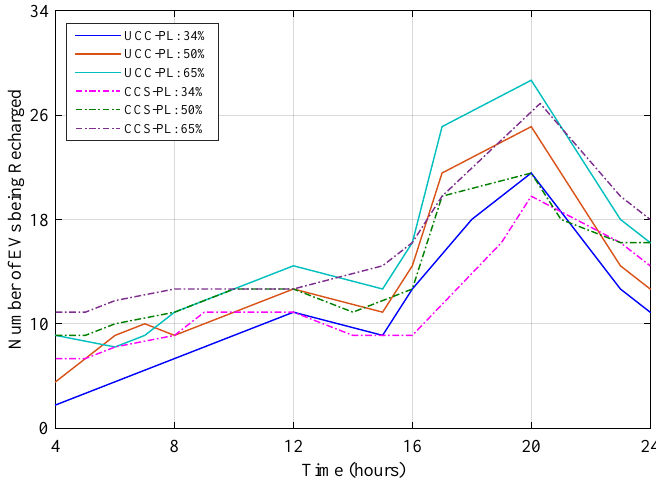
Figure 12. EV charging pattern during a typical day of